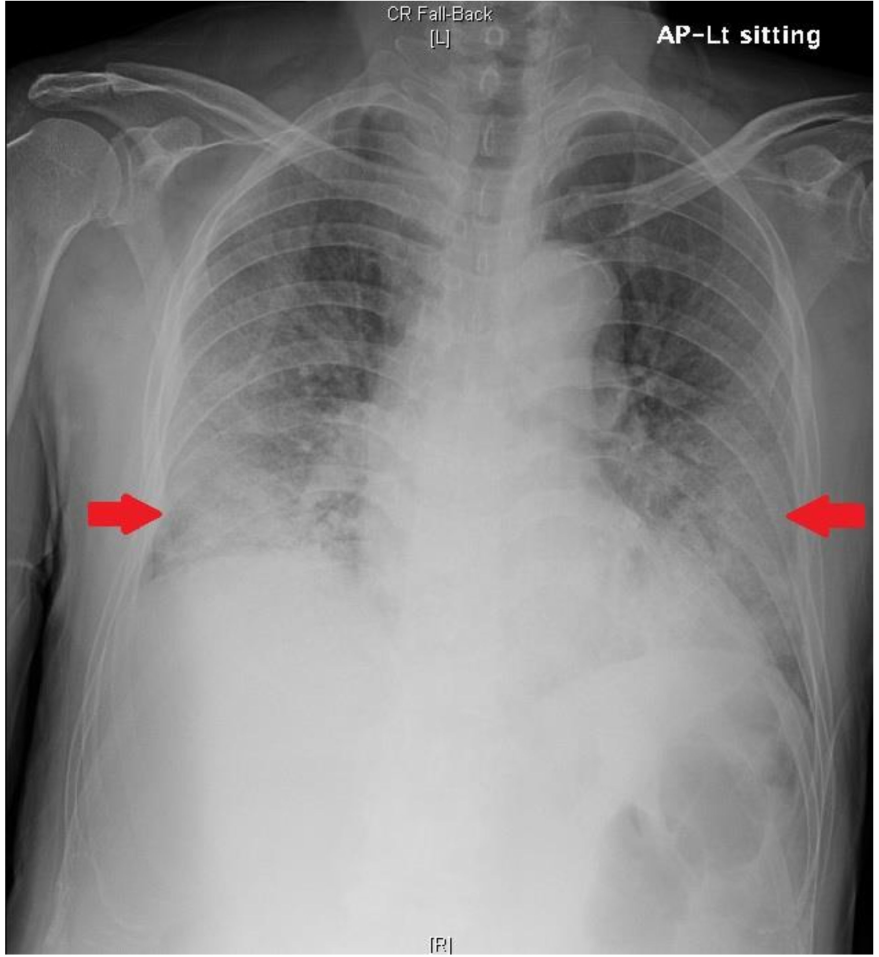
Figure 1. Chest radiograph obtained on day 6 of hospitalization shows haziness in both lower lung fields (red